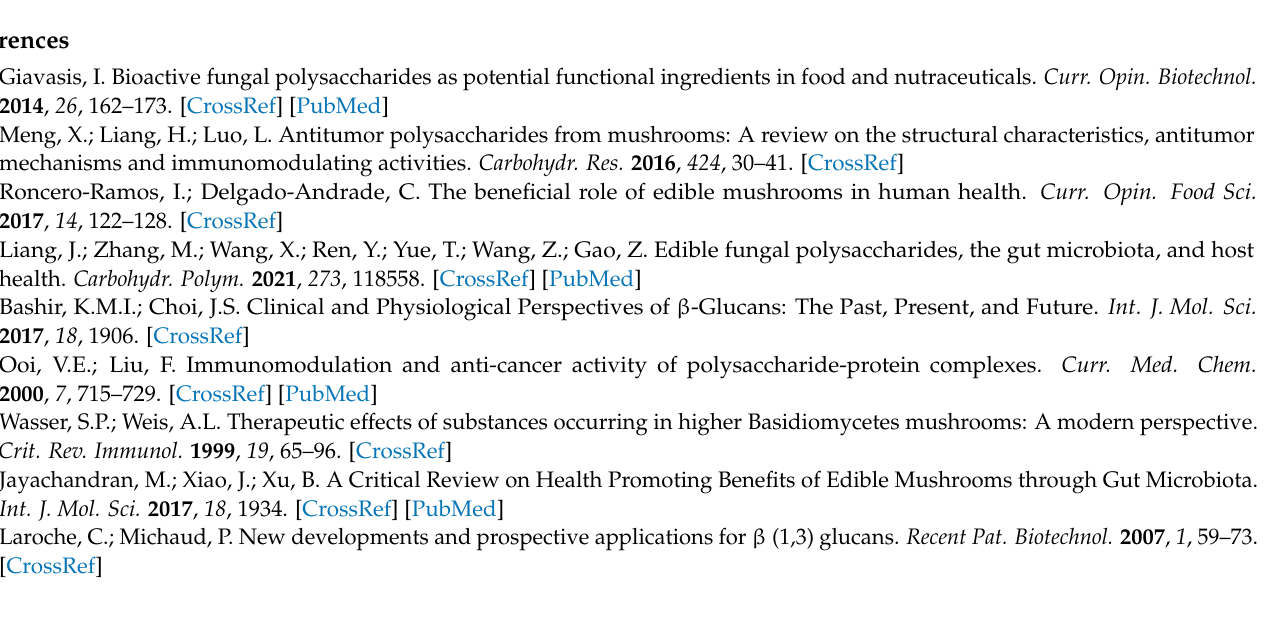
Figure S2. viSNE maps of all 30 markers of the MDIPA panel. Table S1. Pathsetter cell-type definitions. Table S2. Pathsetter analysis on Maxpar Direct Immunophenotyping Assay of treated